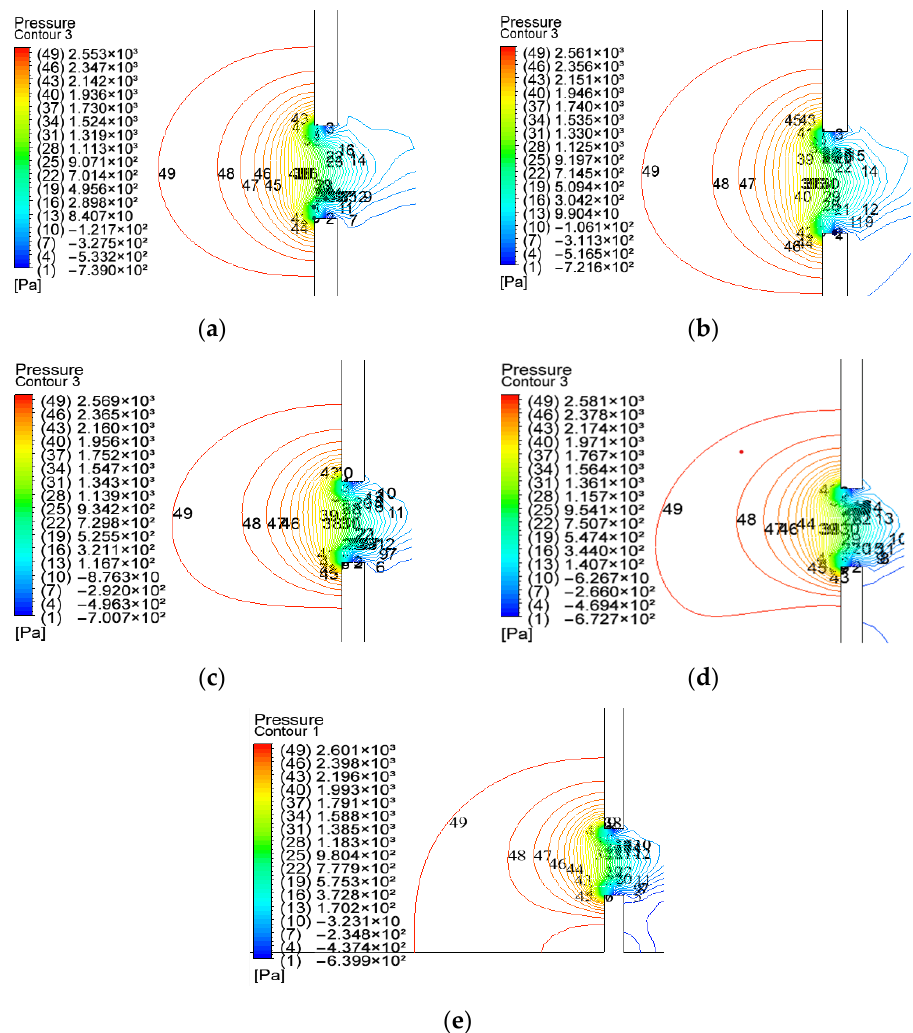
Figure 7. Contour lines of air pressure at personnel door. ( a ) 200 mm; ( b ) 400 mm; ( c ) 600 mm; ( d ) 800 mm; ( e ) 1000 mm.